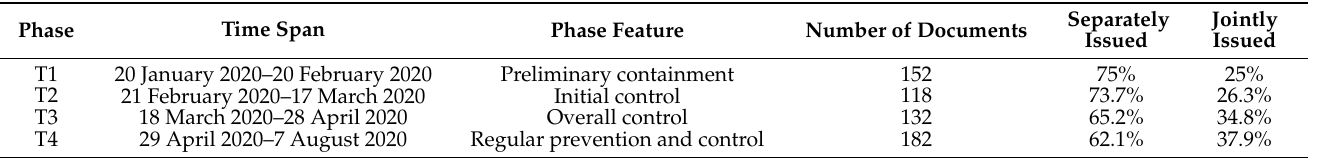
Table 1. Four phases of managing the COVID-19 pandemic in China. Phase Time Span Phase